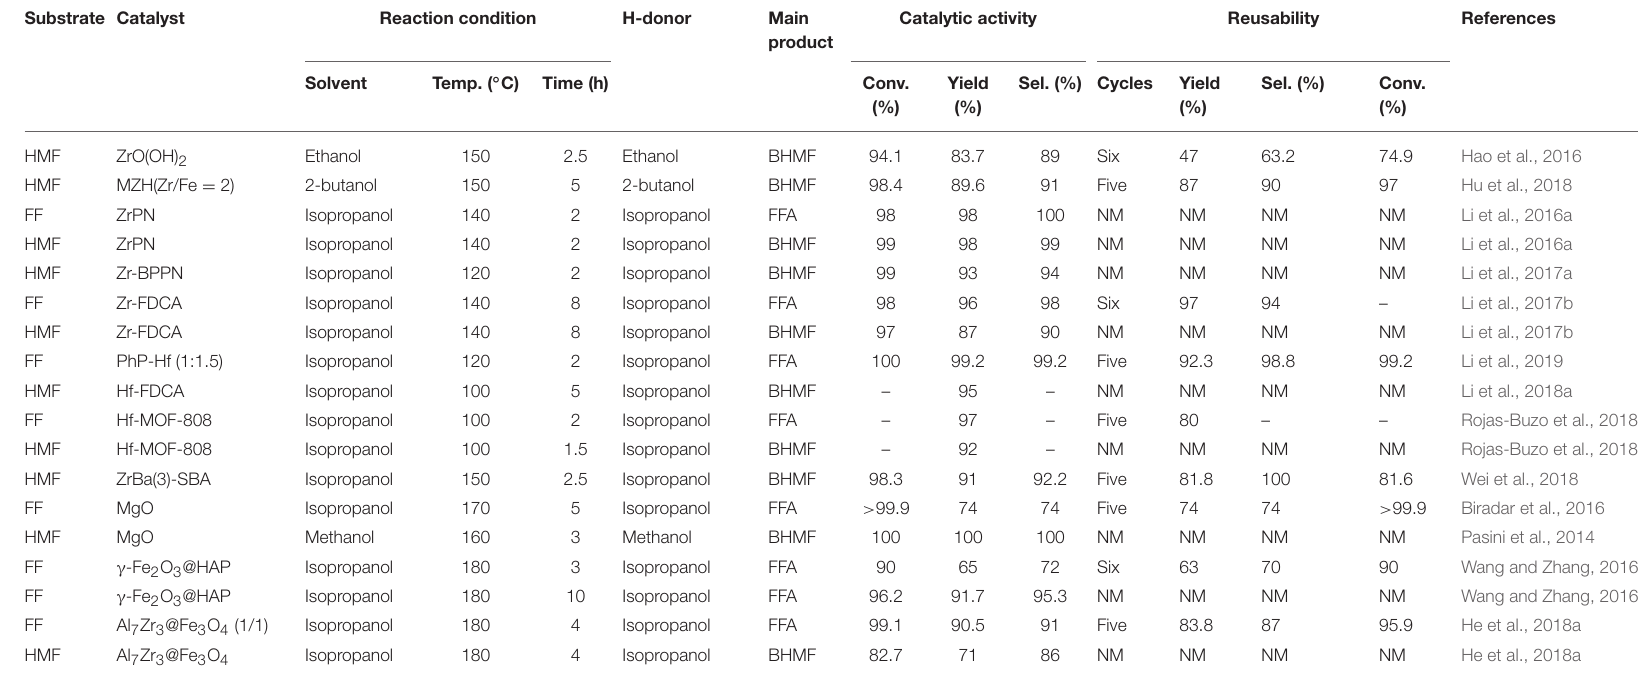
TABLE 3 | Reduction of FF and 5-hydroxymethylfurfural catalyzed by various acid-base catalysts. Substrate